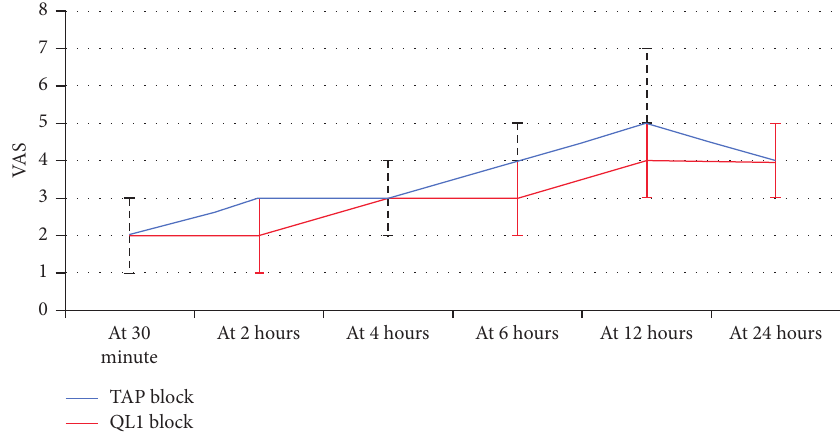
Figure 2: VAS scores among different study